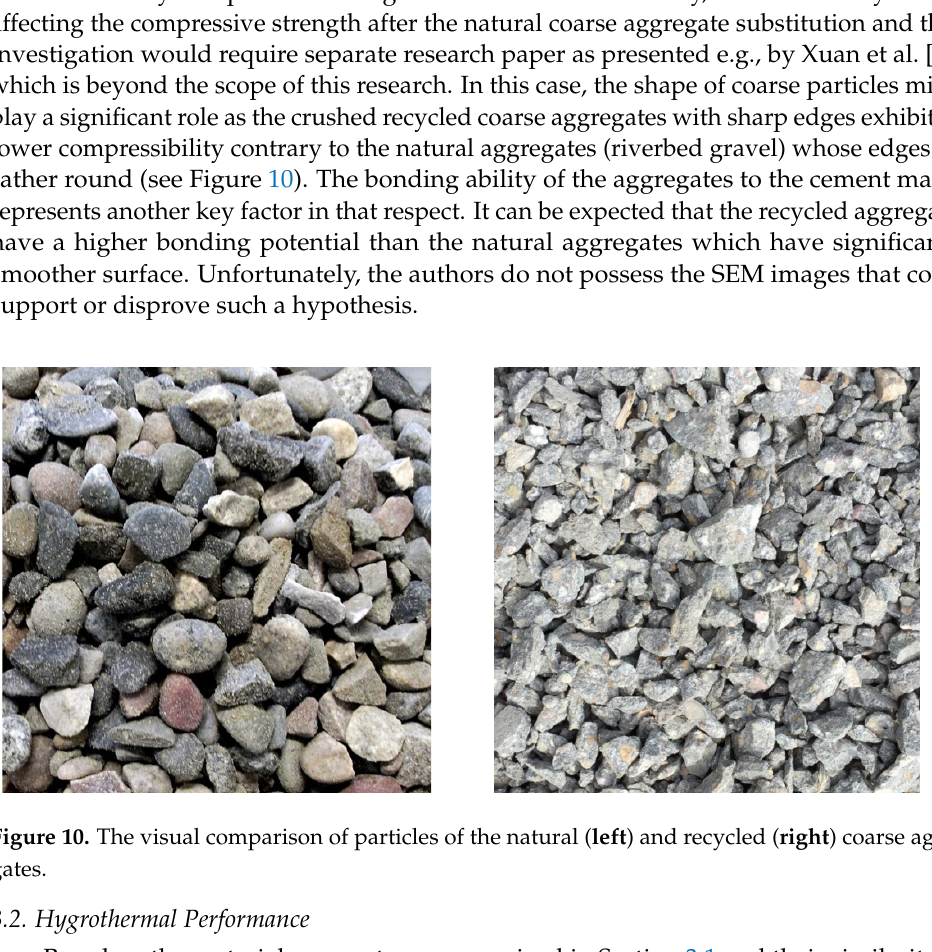
10 of 17 Figure 9. The splitting tensile strength test: a samplebefore (left) and after (right) the testing proce- dure. Table 4. Mechanical properties.